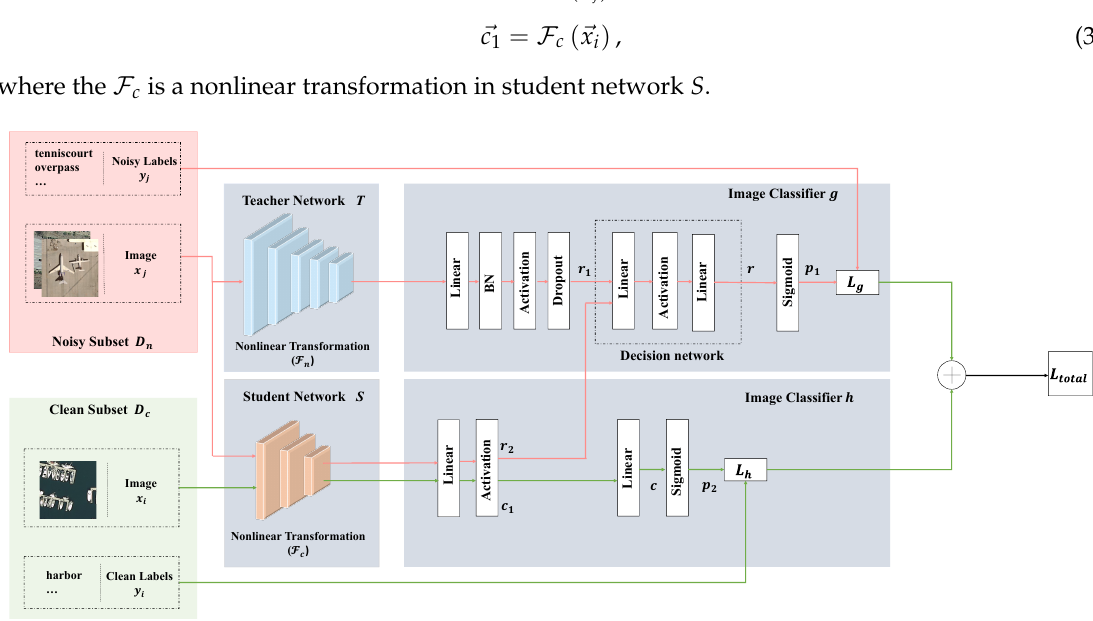
Figure 2. The overview of the proposed framework to train a remote sensing scenes classifier from a large dataset D n with noisy labels and a small dataset D c with manually verified labels. The framework consists of teacher network T , student network S , decision network, fully connected layers, and predictor of softmax. In the training phase, two loss terms L g and L h (a CE loss with noisy labels and a CE loss with clean labels) are minimized jointly. The teacher model T transfers the “dark knowledge” distilled from noisy subset to the student model S through the decision network. In the inference phase, a classifier containing the student network S , fully connected layers and softmax can give the correct